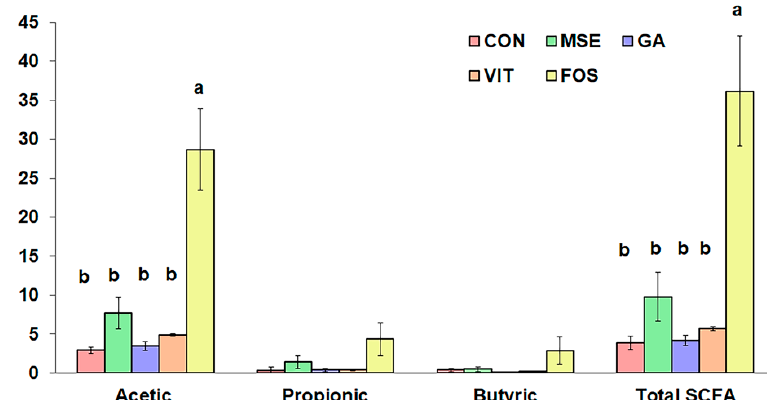
Figure 1. Comparison of short-chain fatty acid (SCFA) concentrations following 24 h of fecal fermentation with mung bean seed coat extract (MSE), gallic acid (GA), vitexin (VIT), fructo-oligosaccharide (FOS), and no added substrate (control; CON). Values are means ± standard error of the mean (SEM) ( n = 3). Means with different letters in the same SCFA are significantly different ( p < 0.05).